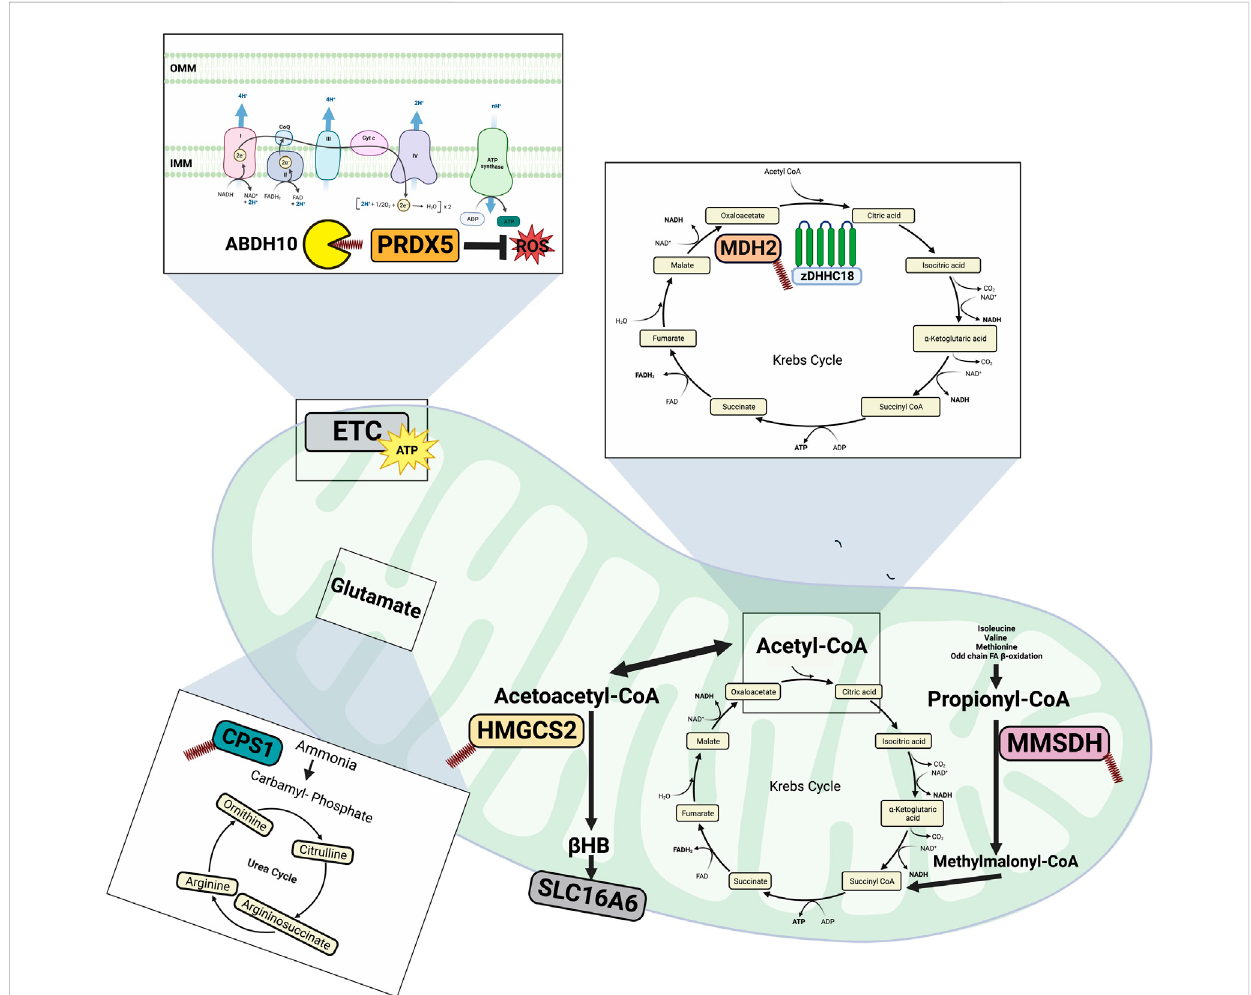
FIGURE 2 Overview of mitochondrial protein palmitoylation. CPS1 palmitoylation inhibits its catalytic activity thereby reducing amino acid degradation and urea synthesis during starvation. Through depalmitoylation by ABDH10, PRDHX5 regulates mitochondrial antioxidant ability. HMGCS2 is involved in generating ketones ( β HB) and its palmitoylation has been implicated in mediating its interaction with PPAR α , suggesting a role for palmitoylation in regulating transcription. MDH2 is an important Krebs cycle enzyme and its activity is enhanced following its palmitoylation by zDHHC18. MMSDH is part of the distal portions of the valine and pyrimidine pathway and has been observed to undergo spontaneous autopalmitoylation in response to mitochondrial levels of long chain fatty acyl-CoAs. Made on